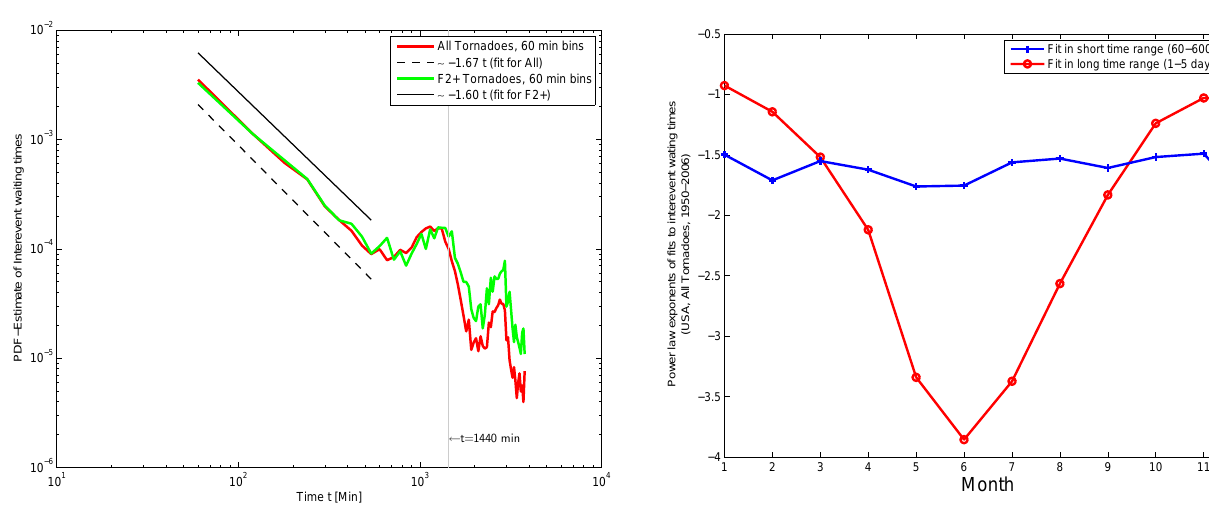
Fig. 4. Monthly analysis of the interevent waiting times of US tor- nadoes (1950–2006): Plotted are the exponents of the power law fits ( = slopes of linear fits to double-logarithmic plotted data) in differ- ent time regimes: short time range up to 600min (blue line, fit time range for every month: 60 to 600min, data in 60min bins) and long time range starting with 1 day (red line, fit time range for every month: 1 to 5 days, data in 1440min